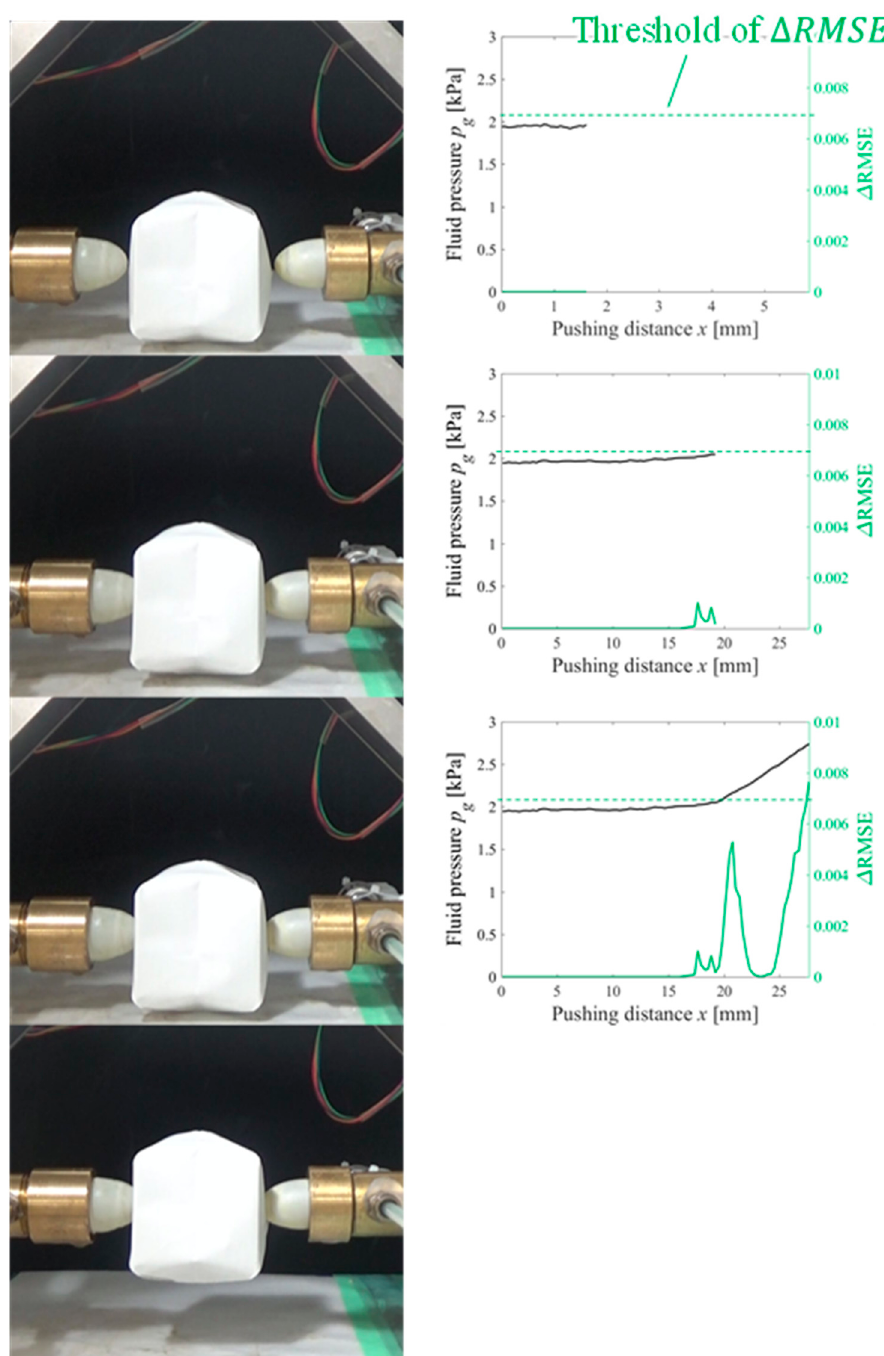
Figure 12. Overview of the grasping test (origami target)